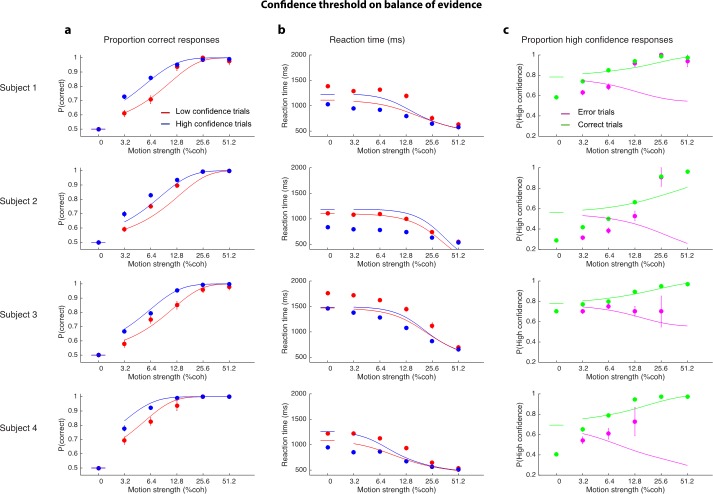
Fits to alternative model 1 that uses a threshold on the balance of evidence (BoE) to assign confidence and ignores time.Graphs follow the same format as in Figure 2 and display the same data (symbols) and axes. The BoE will tend to be greater with longer times. Therefore, this model produces a qualitative mismatch in the middle column. It also predicts that confidence on errors should decrease as a function of motion strength (magenta curves, 3rd column).